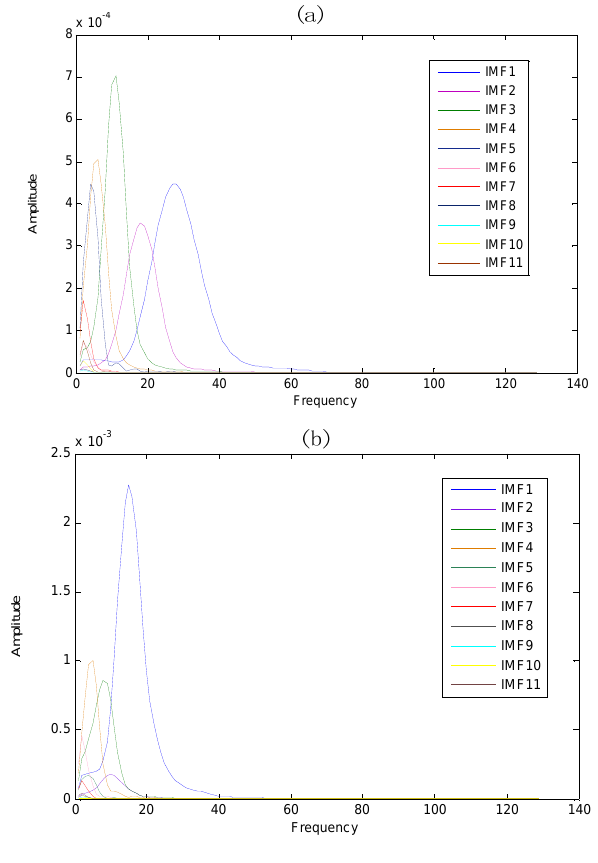
Figure 5. Corresponding IMF spectrum distribution of ( a ) EMD and ( b )